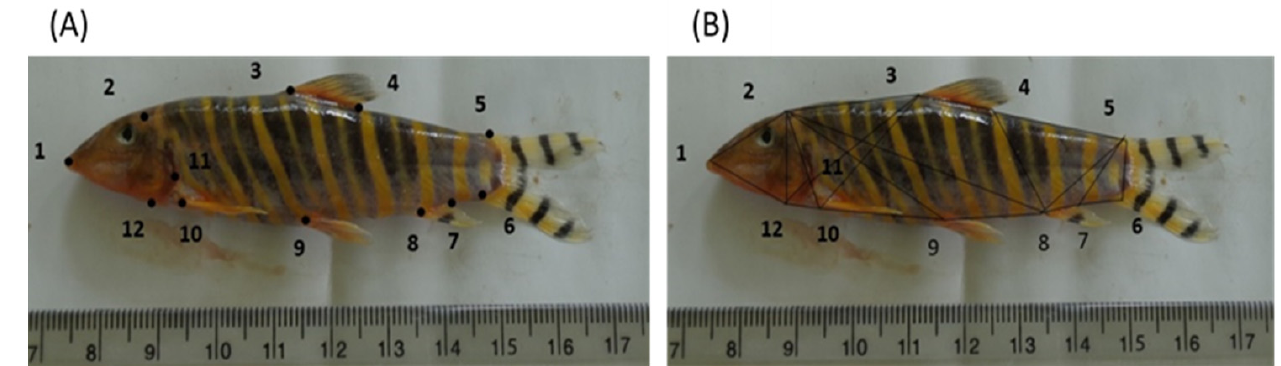
Figure 2. ( A ) Position of 12 anatomical landmarks of Botia dario for creating 23 truss networks on fish body illustrated as a close circle (black). The explanations of landmarks are followed: (1) anterior tip of the upper snout, (2) origin of the dorsal fin base, (4) endpoint of the dorsal fin base, (5) dorsal origin of caudal fin, (6) ventral origin of the caudal fin, (7) endpoint of the anal fin, (8) origin of anal fin, (9) endpoint of the pelvic fin, (10) origin of pectoral fin, (11) endpoint of opercula, (12) ventral insertion of the opercula. ( B ) Illustrated photograph of Botia dario comprising 12 landmarks for assembling the truss network.